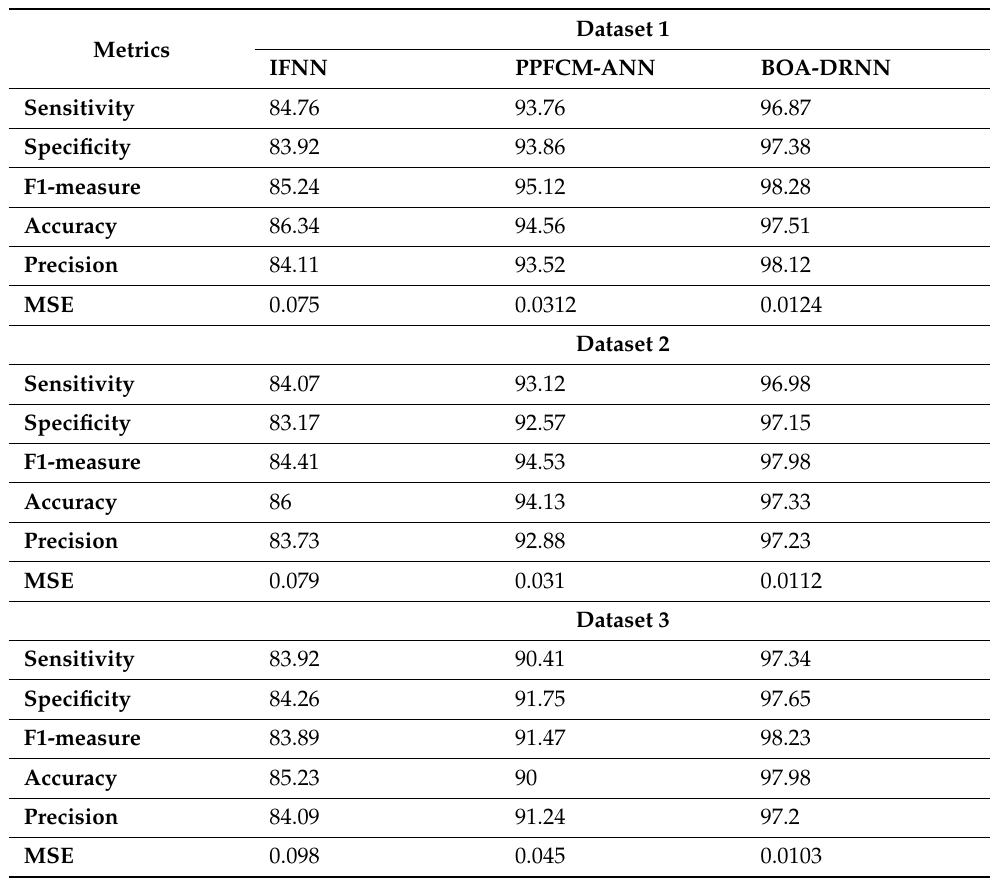
Table 4. Efficiency